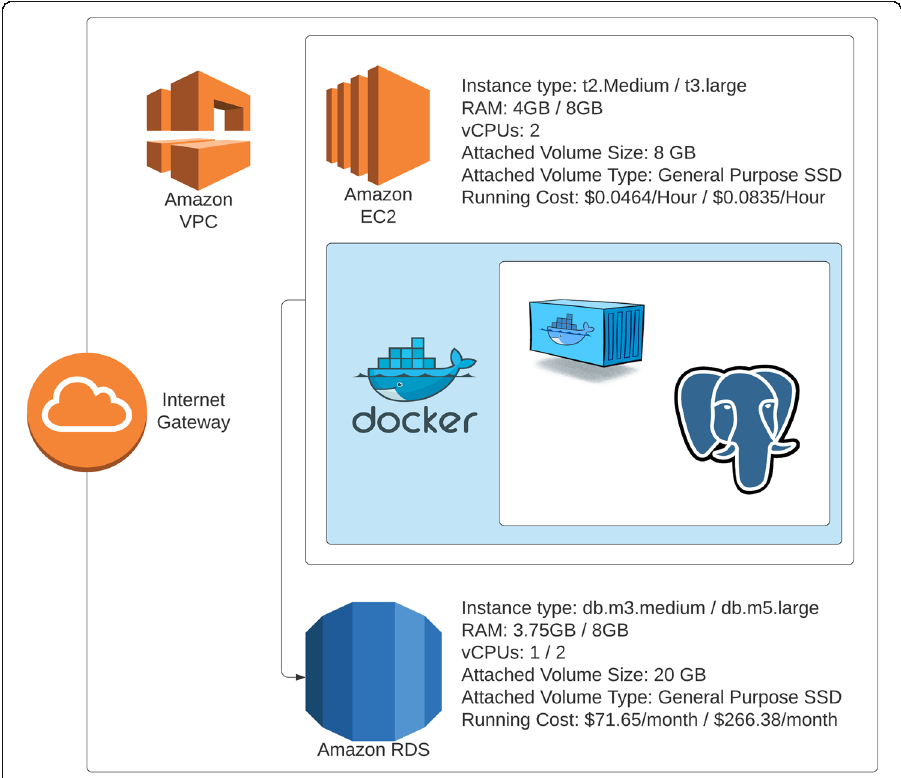
Fig. 3 Cloud infrastructure setup for deploying PostgreSQL/PostGIS on AWS RDS